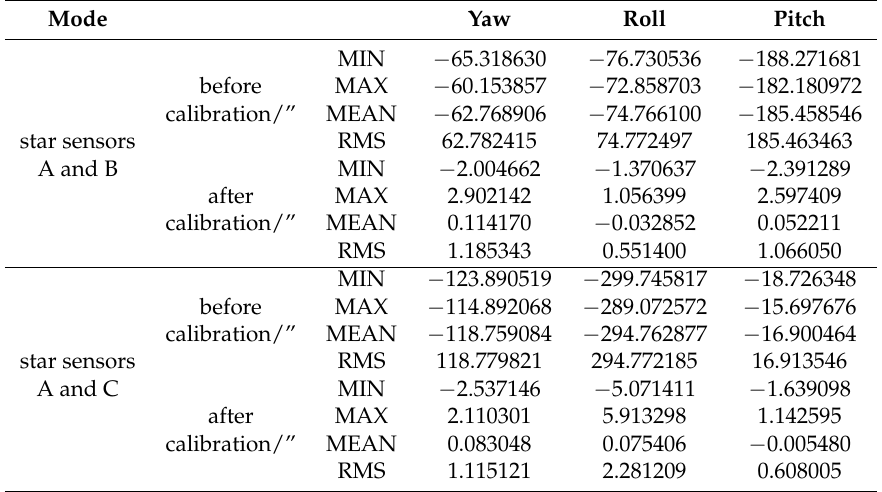
Table 7. The attitude determination consistency for different star sensor combined